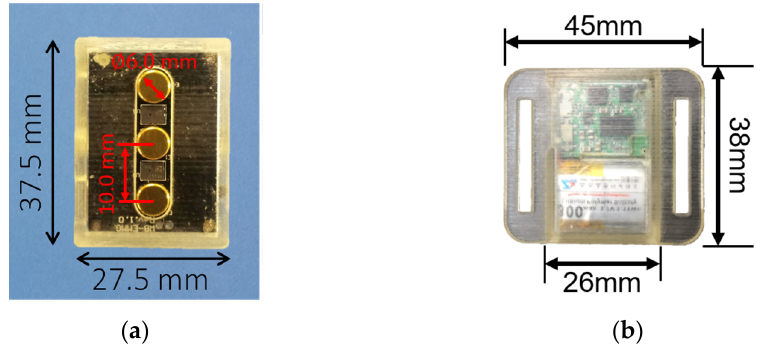
Figure 2. WB sensors: ( a ) WB-EMMG sensor and ( b ) WB-4 IMU sensor. Table 1. Specification of WB-EMMG sensor used in the experiment.